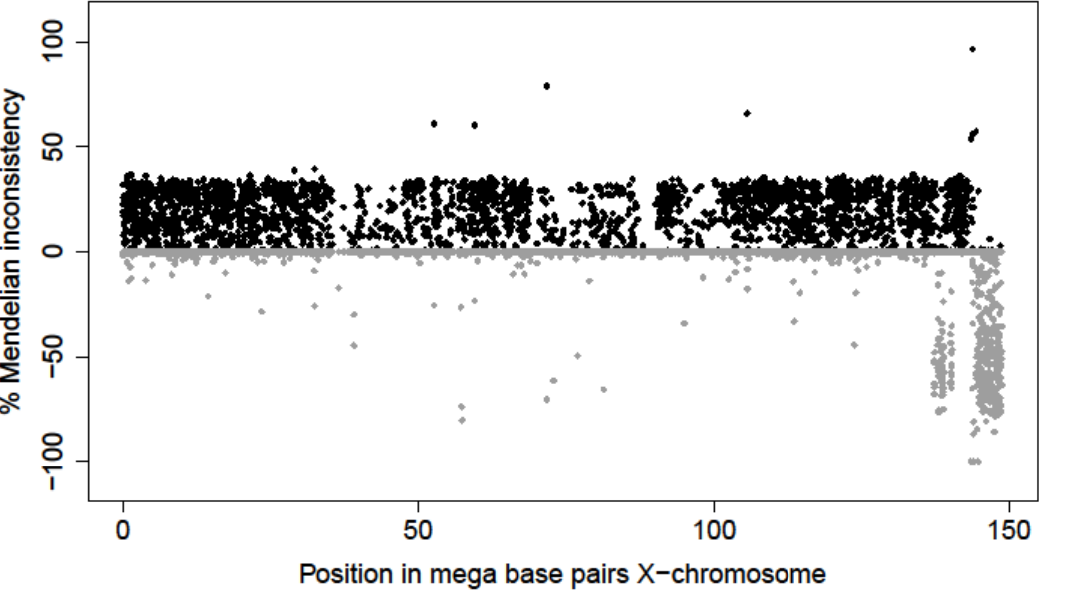
Figure 1. Mendelian inconsistencies across bovine X-chromosome based on the pseudoautosomal inheritance model (positive value and black color) and the heterosomal inheritance model (negative values and grey color).